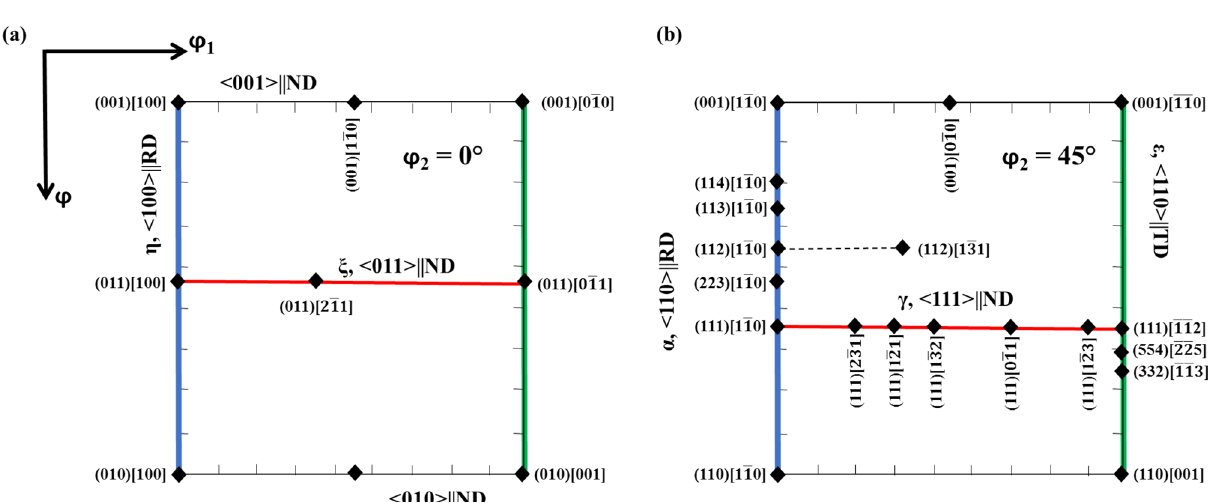
Figure 4. ( a ) φ 2 = 0° section and ( b ) φ 2 = 45° section of the Euler space along with some common orientations and fibers that occur in BCC metals and